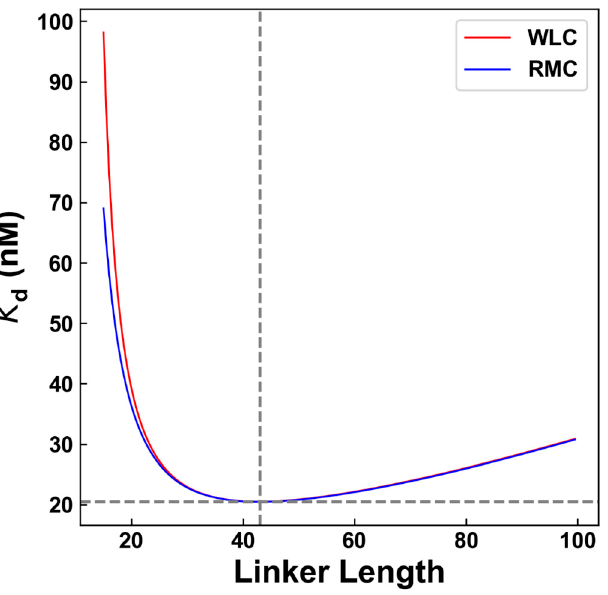
Figure 3. Prediction of the optimal IDL linker length to achieve the strongest binding affinity to DNA, using a WLC model (red line) and a RMC model (blue line). The dotted grey line indicated the optimal linker length (43 residues), under which the predicted K d is the minimum (20.5